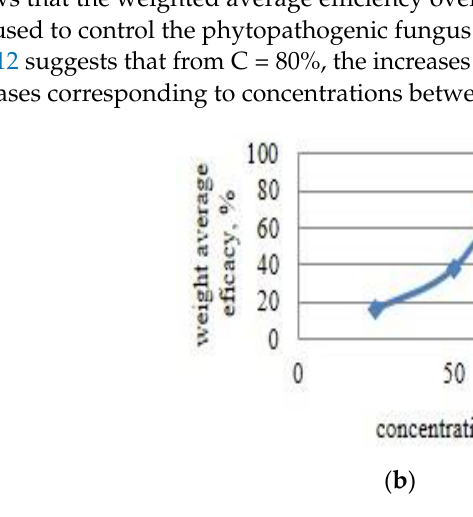
Figure 12. The dependence of the average temporal efficacy on the concentration, for EO 1 ( a ) and EO 2 ( b ) against F. oxysporum.